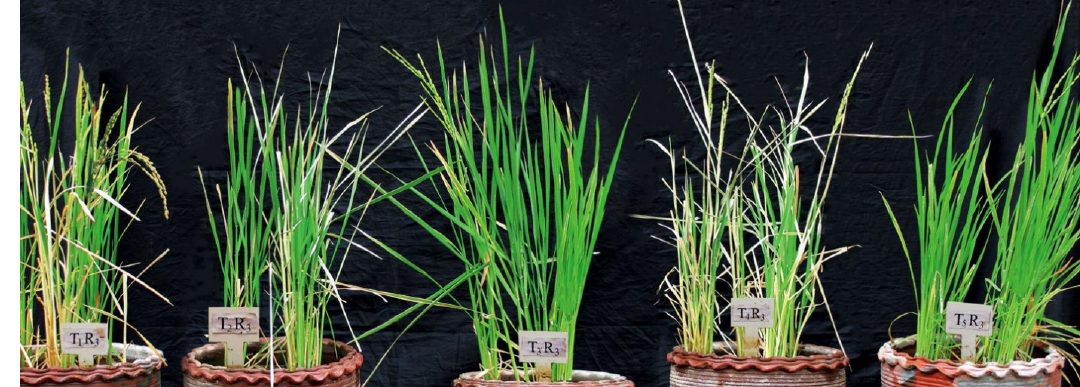
Figure 10. Photo of illustrating experimental setup. The rice plants during the flowering stage (70 days after sowing (DAS)) after 10 days of drought stress are shown. From left to right, the treatments are as follows: PB3, drought stress with B. endophyticus PB3 foliar spray; PB46, drought stress with B. altitudinis PB46 foliar spray; PB50, drought stress with B. megaterium PB50 foliar spray; Cws, drought stress control; and CI, irrigated control. R 3 is the replicate 3 of each